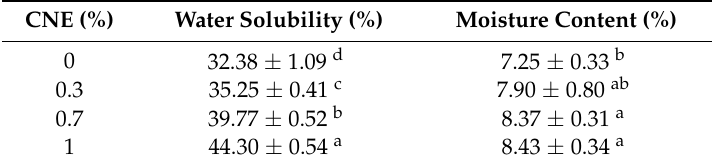
Table 6. Water solubility and moisture content of ABS films containing various amounts of cocoa nibs